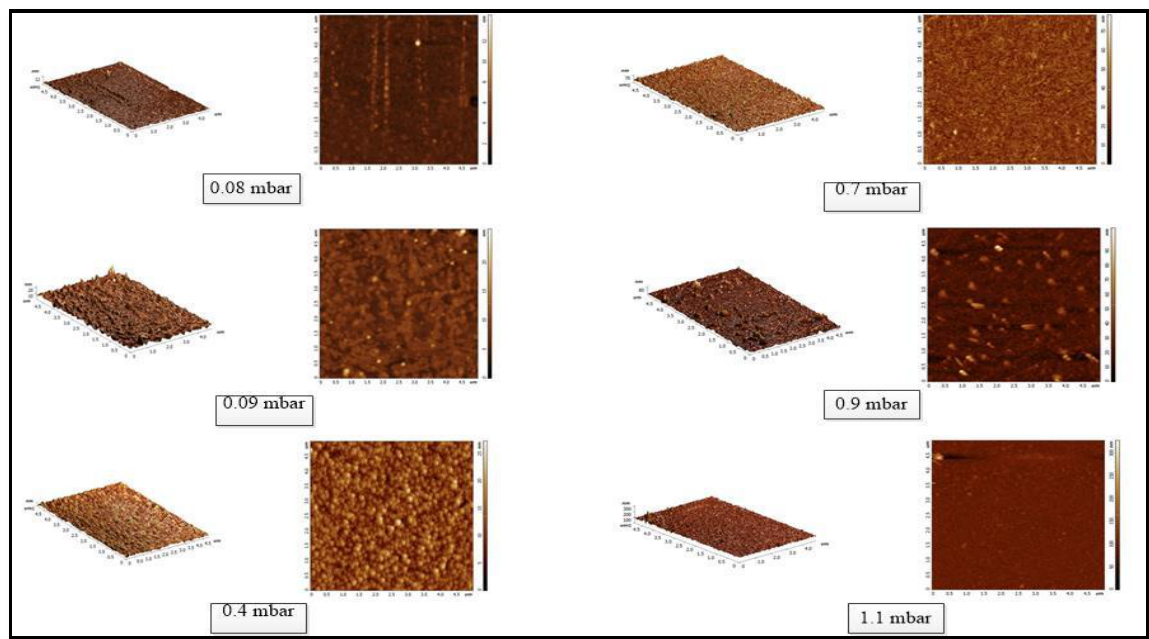
Fig. 3: 2D and 3D AFM images of Ag thin film deposited at different working pressure.